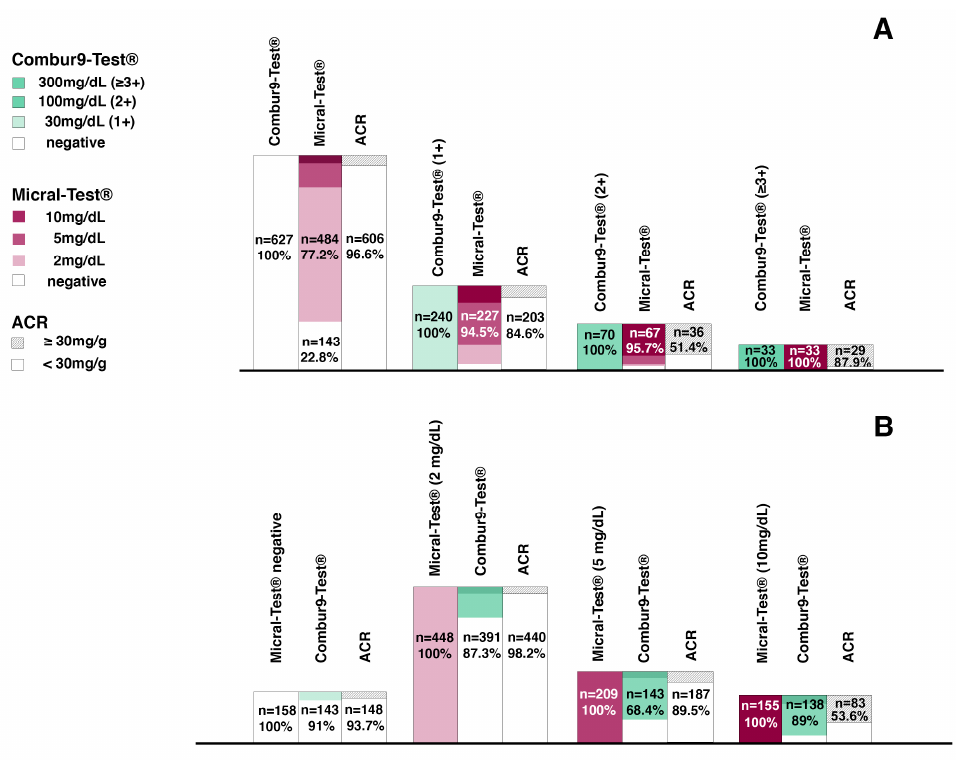
Figure 4. Agreement of Combur9-Test ® and Micral-Test ® with the albumin-to-creatinine ratio (ACR). ACR as reference test with cut-off ≥ 30mg/g. ( A ) Colorimetric urinary dipstick Combur9-Test ® results compared to the albumin-to-creatinine ratio and to the immunochromatographic Micral-Test ® ; ( B ) immunochromatographic Micral-Test ® results compared to the albumin-to-creatinine ratio and to the colorimetric urinary dipstick Combur9-Test ® ; ACR: albumin-to-creatinine